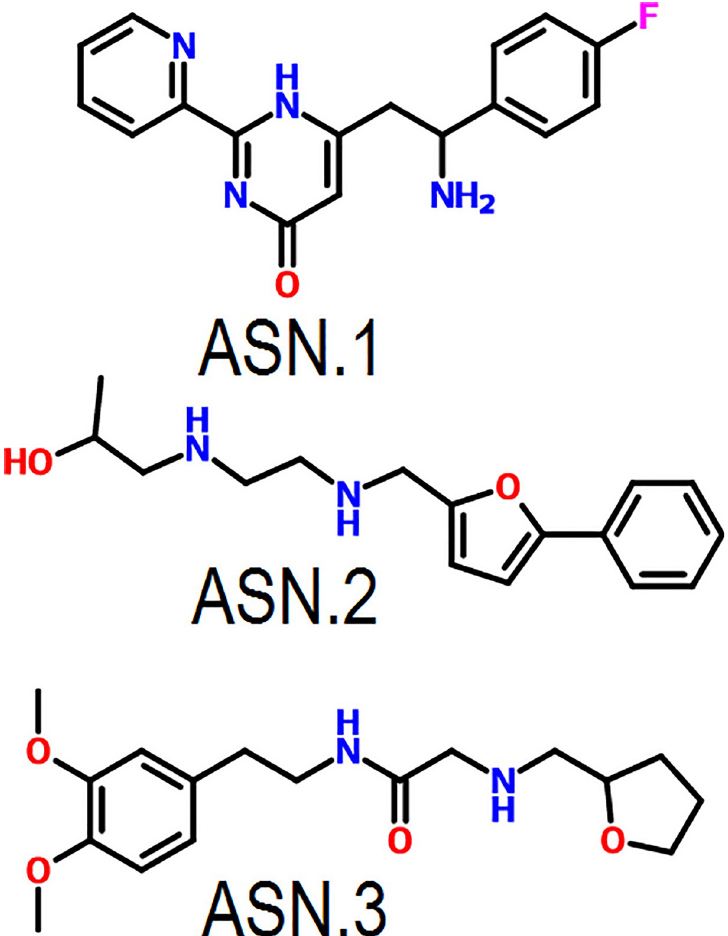
Fig 4. Structures of the three primary hits which showed good schizonticidal activity.